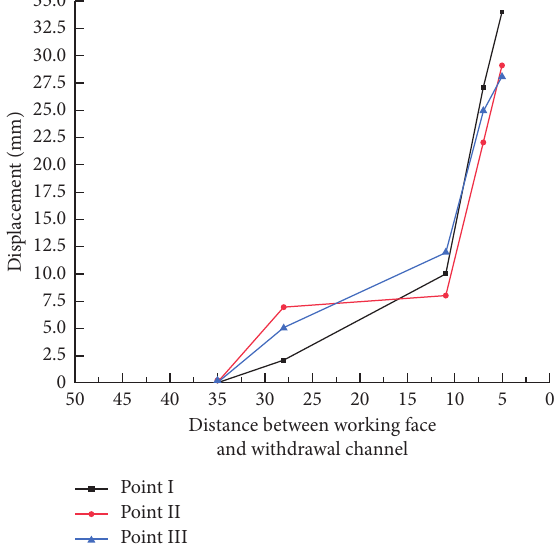
Figure 22: Roof and floor displacement of main withdrawal channel.